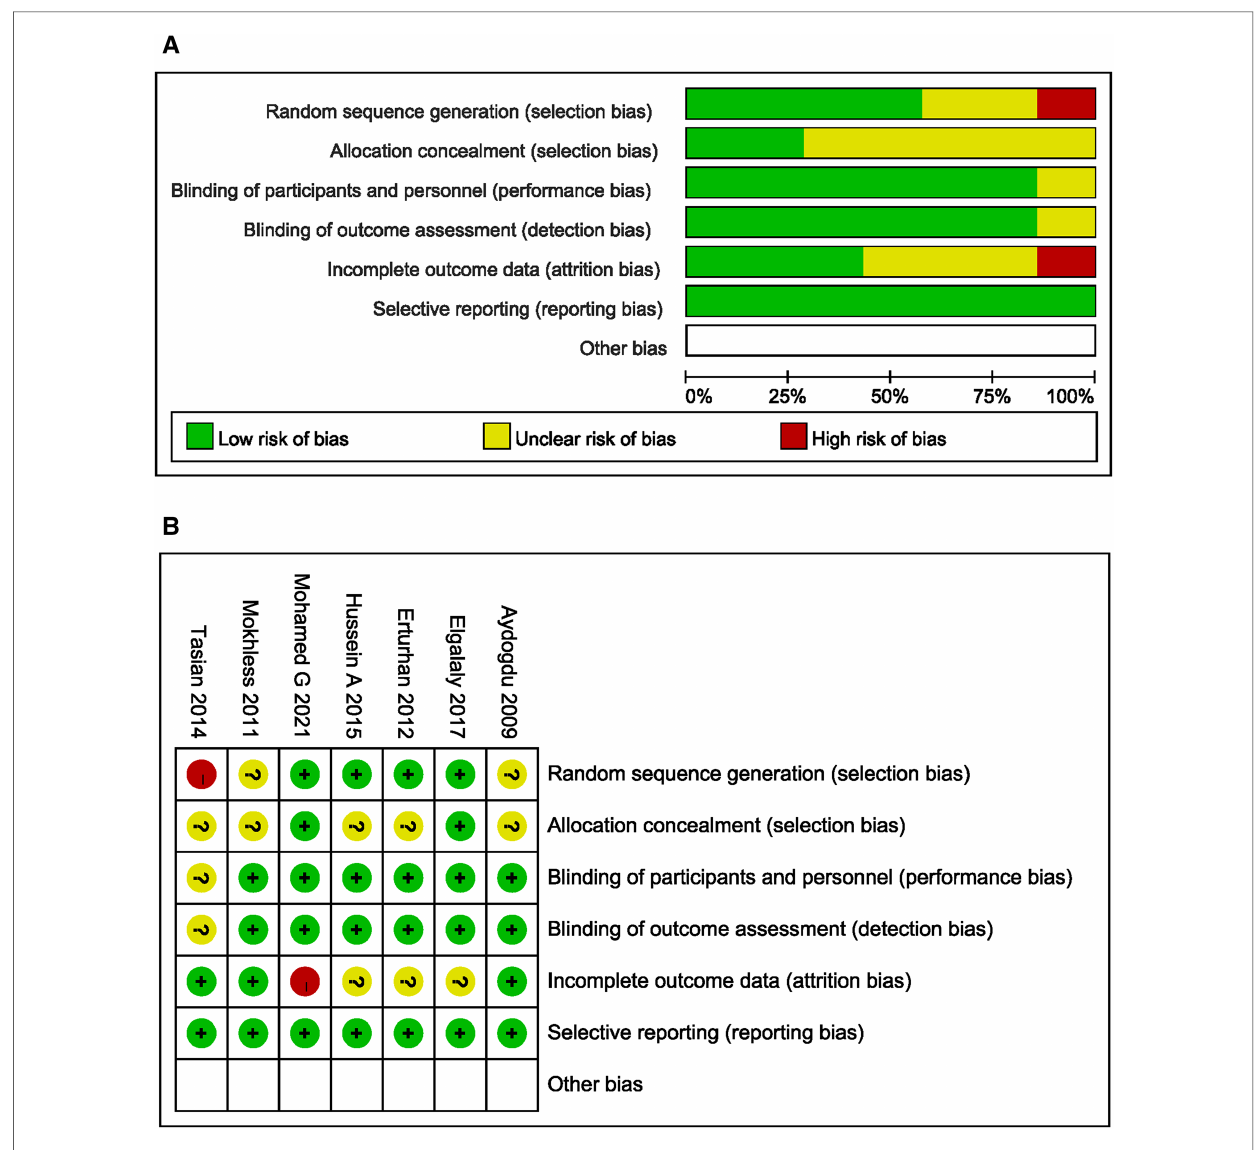
FIGURE 2 Bias risk assessment of included studies. ( A ) Risk of bias summary: Each bias risk item of all included studies was judged by review authors. ( B ) Risk of bias graph: The review authors quanti fi ed each bias risk item of included studies as a